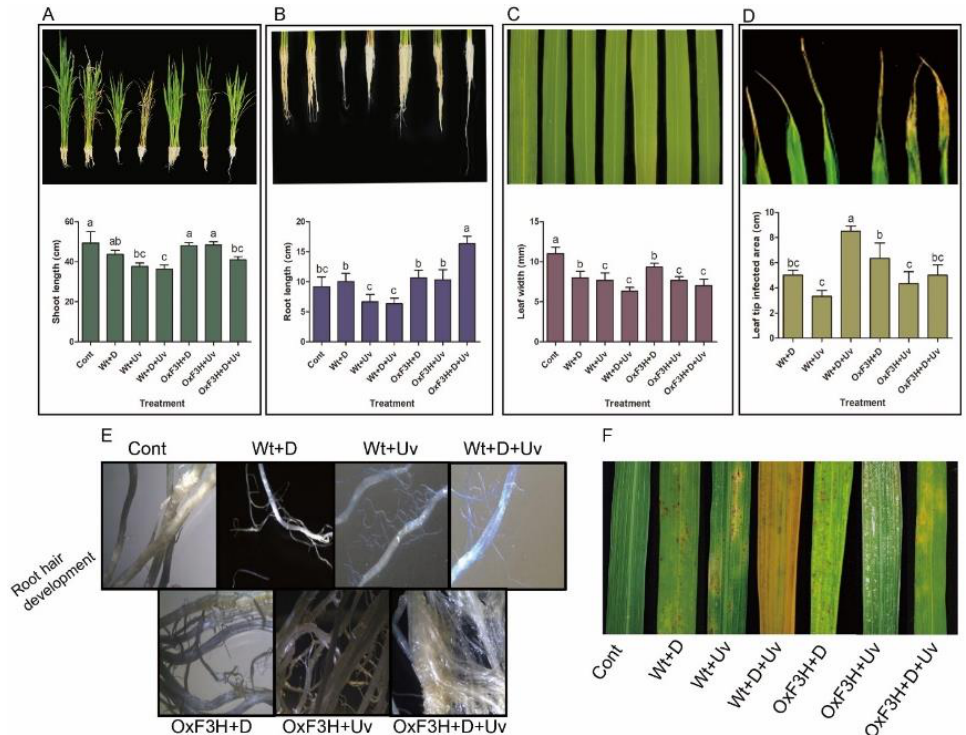
Figure 2. Evaluation of growth parameters in wild and transgenic rice plants under drought and UV-B radiation stress. ( A ) Shoot length, ( B ) root length, ( C ) leaf width, and ( D ) leaf tip damaged due to stress. In each box, the upper part is graphical, while the lower part is a pictorial representation of each phenotype. ( E ) The root hair development in in wild and transgenic plants and ( F ) symptoms appearing on leaves under different stresses. Each data point in ( A – D ) is the mean of three replicates. Error bars represent standard errors. The bars shown with different letters are significantly different from each other as evaluated by DMRT analysis.